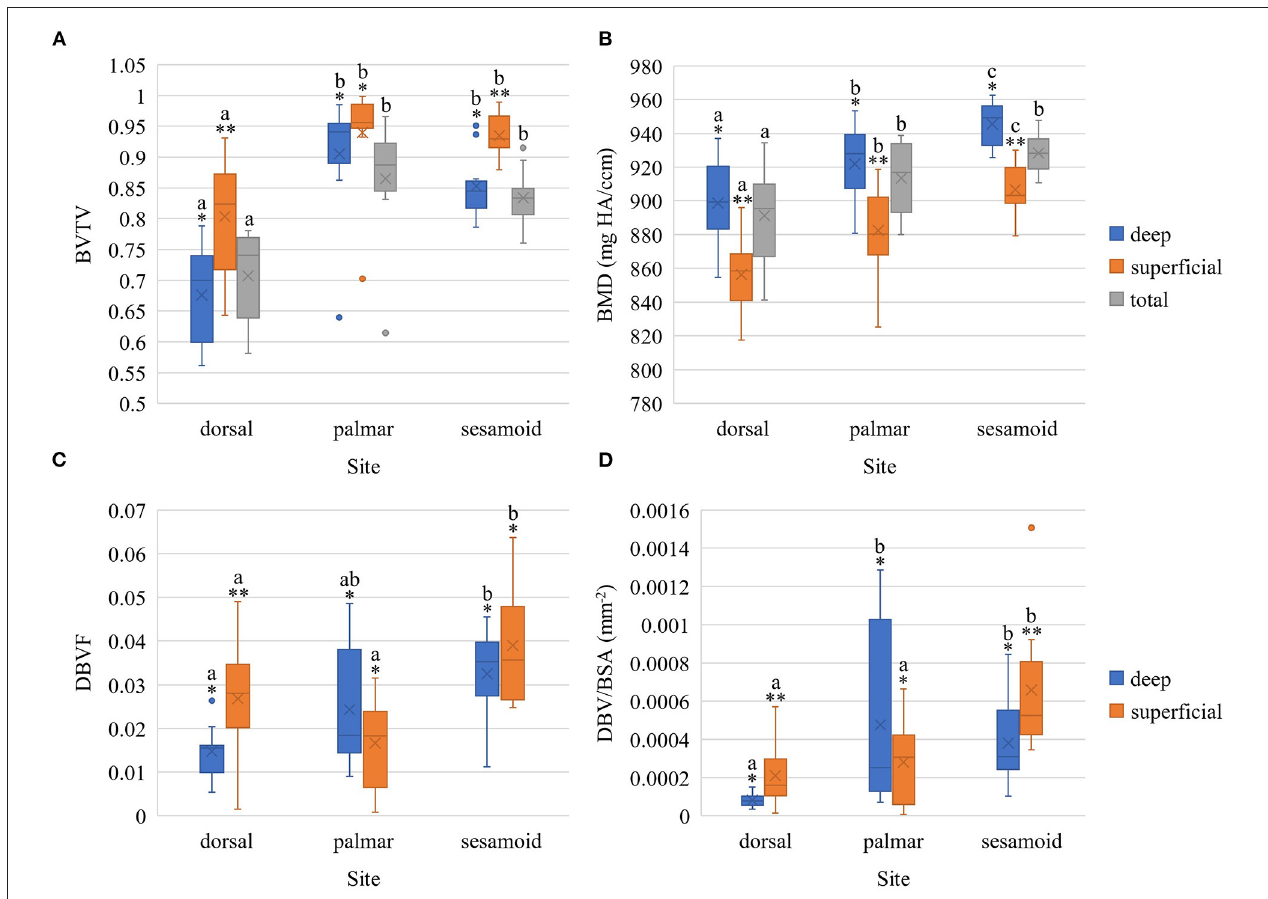
FIGURE 4 | Boxplots of bone volume fraction (A) , bone mineral density (B) , damaged bone volume fraction (C) , and adjusted damaged bone volume fraction (D) within the metacarpophalangeal joint of Thoroughbred racehorses [ n = 10 except for (C) and (D) where n = 9 in the deep dorsal site] stratified by site (palmar MCIII, dorsal MCIII, proximal sesamoid) and by layer (superficial 2mm, deeper 2mm, or total ∼ 10mm thick specimen). BVTV, bone volume fraction; BMD, bone mineral density in mg HA/ccm; DBVF, damaged bone volume fraction; DBV/BSA, adjusted damaged bone volume fraction in mm − 2 ; X represents the mean, the horizontal midpoint of the box the median, the lower end of the box the first quartile, the upper end of the box the third quartile, and the “whiskers” extend from the ends of the box to the maximum and minimum values. The dots signify outlier values. *,** Within each site, layers with different asterisk annotations are significantly different ( P < 0.05). Total specimen BVTV and BMD was not compared to superficial and deep as it comprises both. a,b,c Within each layer, sites with different alphabetical annotations are significantly different ( P < 0.05).